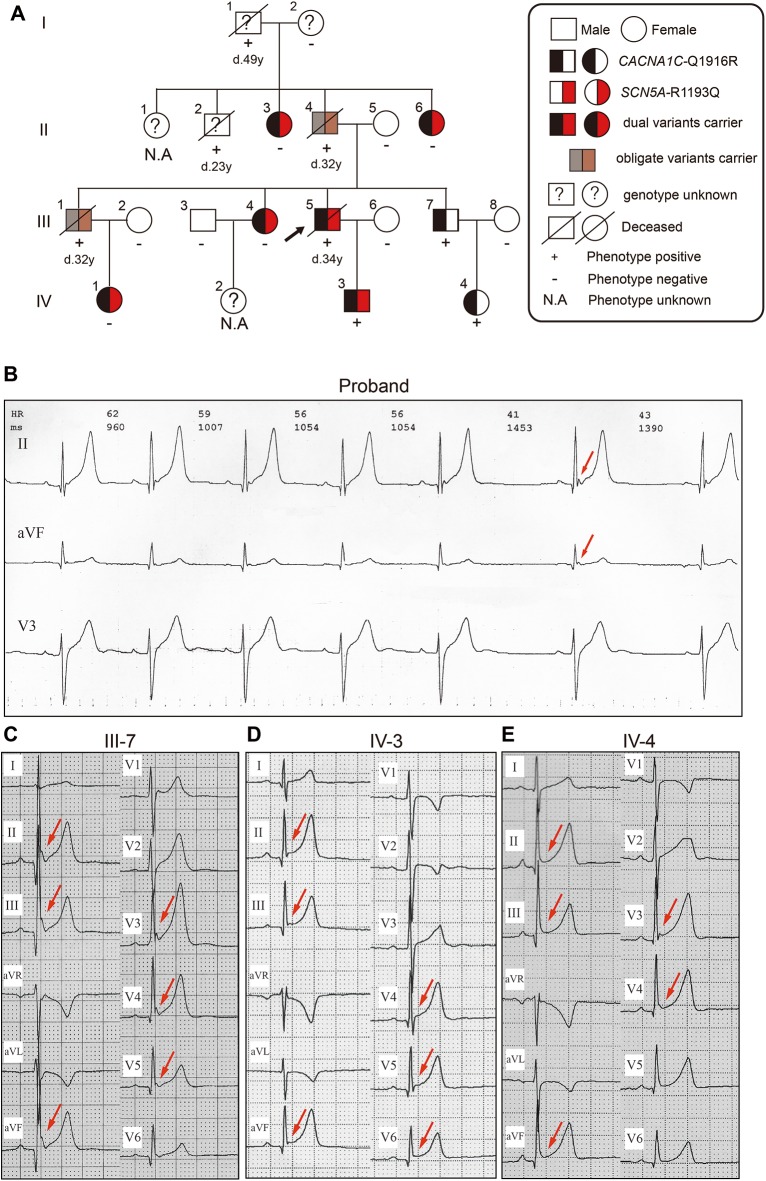
Pedigree and Holter (25 mm/s, 10 mm = 1 mV) results of the family.(A) Phenotypic and genotypic traits are represented by specific symbols in the pedigree. (B) Terminal QRS notch in leads II and aVF (arrows) without ST-segment elevation shown in the Holter of the proband (III: 5). (C) J-point elevation from 1 mm to 3 mm in leads II, III, aVF, and V3—V5 (arrows), which behaved as a terminal QRS notch without ST-segment elevation in III: 7. (d) Terminal QRS notch in leads III and aVF and concave ST-segment elevation (1 mm) in leads II, III, aVF, and V4-V6 (arrows) is presented for IV: 3. (E) Terminal QRS slur with ST-segment elevation in leads II, III, aVF, and V4, and a terminal QRS notch with ST-segment elevation in lead V3 with J-point elevation from 1.5 mm to 2 mm (arrows) is presented for IV: 4.